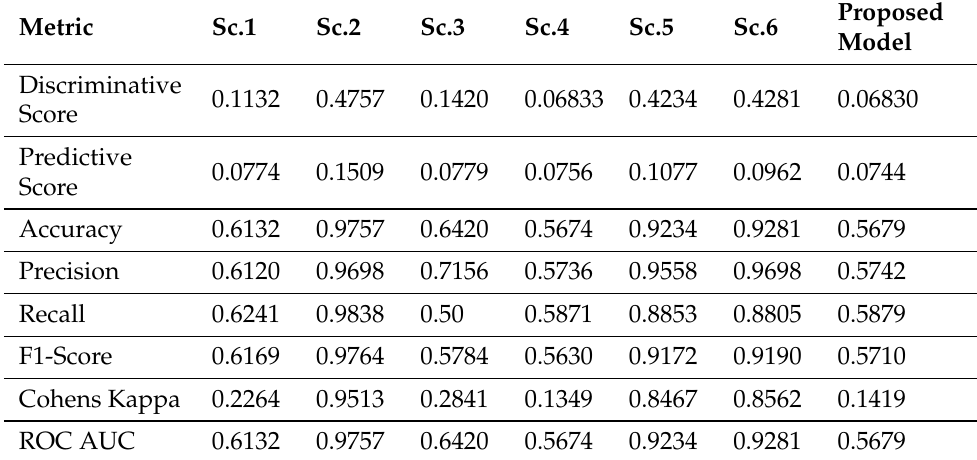
Table 7. Experimental